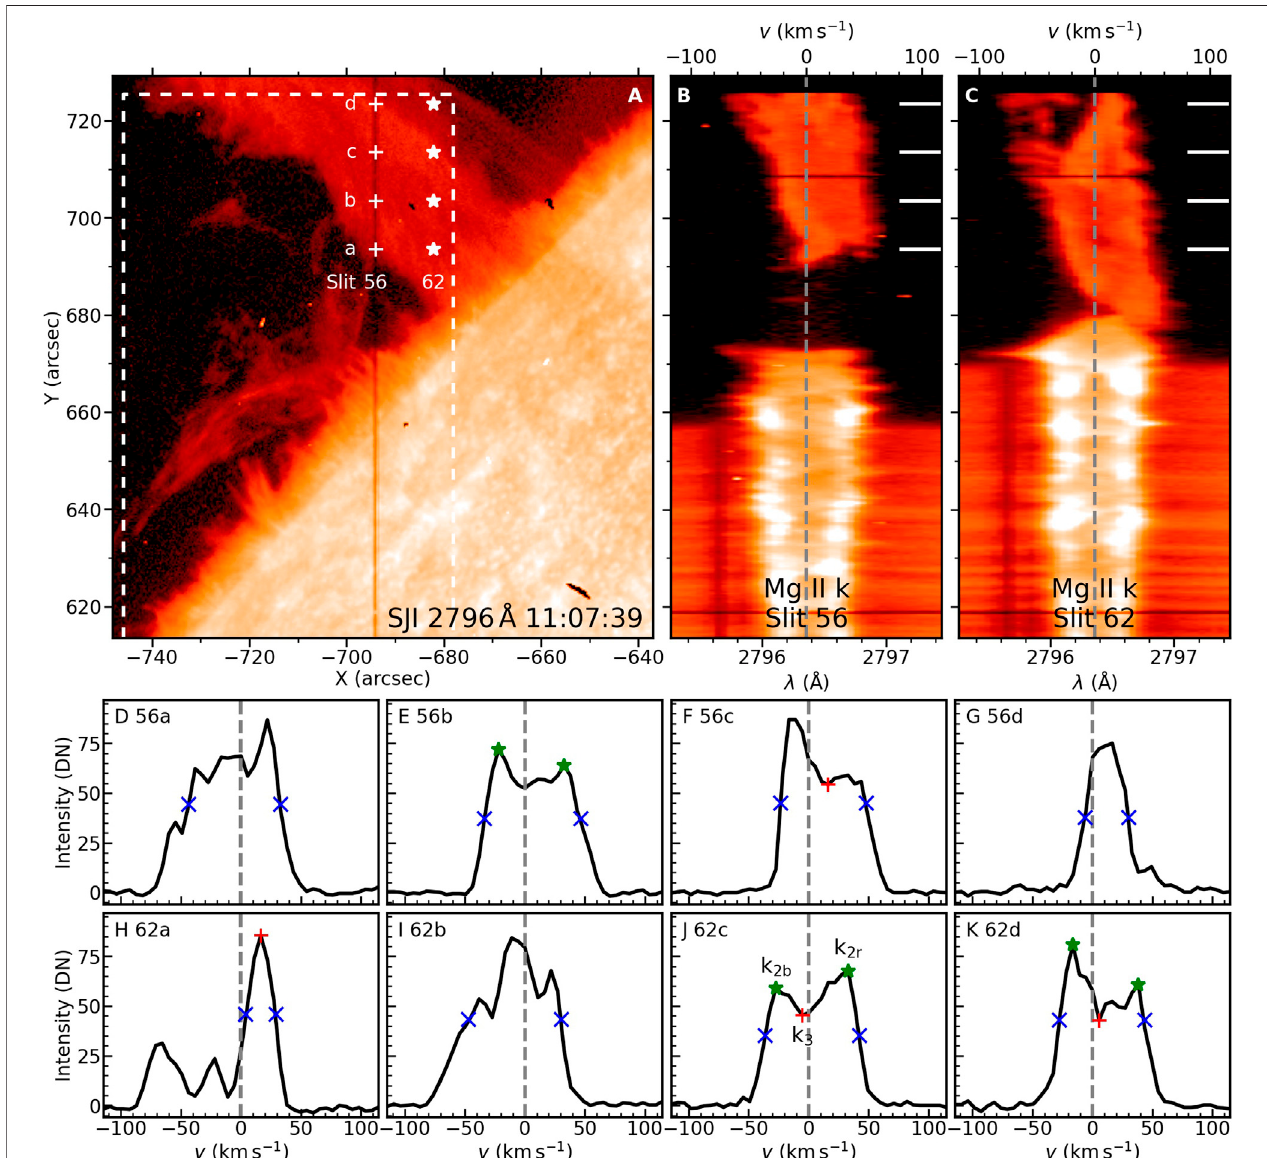
FIGURE 2 | Estimation of LOS velocities from Mg II k line pro fi les. (A) SJI 2796 (cid:1) A. The dashed white lines mark the slit position No.30 (left) , upper boundary of the FOVofMg II raster (top) ,andtheslitpositionNo.64 (right) .Eightpointsmarkedbyplusorstarsymbolsarechosenforanalysisinpanels (D – K) . (B – C) ImagesoftheMg II k spectra along the slit positions No.56 (at 11:07:39 UT) and 62 (at 11:08:44 UT), respectively. The short white lines mark the positions of the spectra in panels (D – K) . TheverticaldashedlinesrepresenttherestwavelengthoftheMg II kline. (D – K) Mg II kpro fi lesatthepositionsmarkedinpanels (A – C) .Theredplusesrepresentthe positions of k 3 , the green stars represent k 2 , and the blue × symbols represent the positions of half maximum.